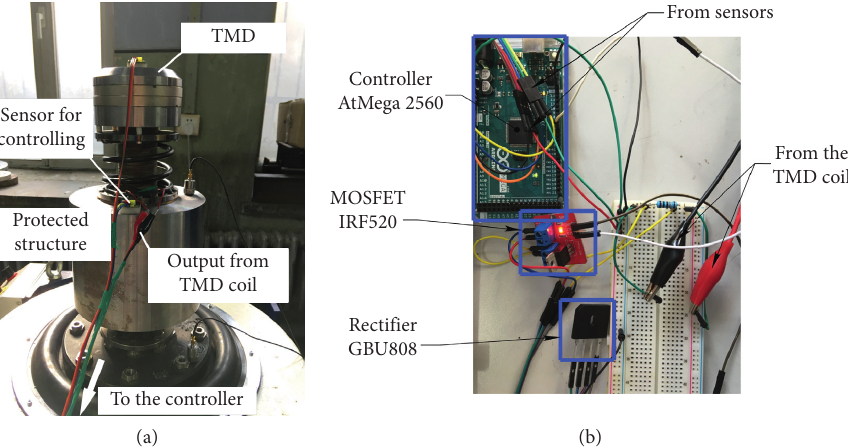
Figure 6: (a) Setup of the 2-DOFs TMD prototype fixed in the protected structure. (b) Experimental layout of the control circuit.